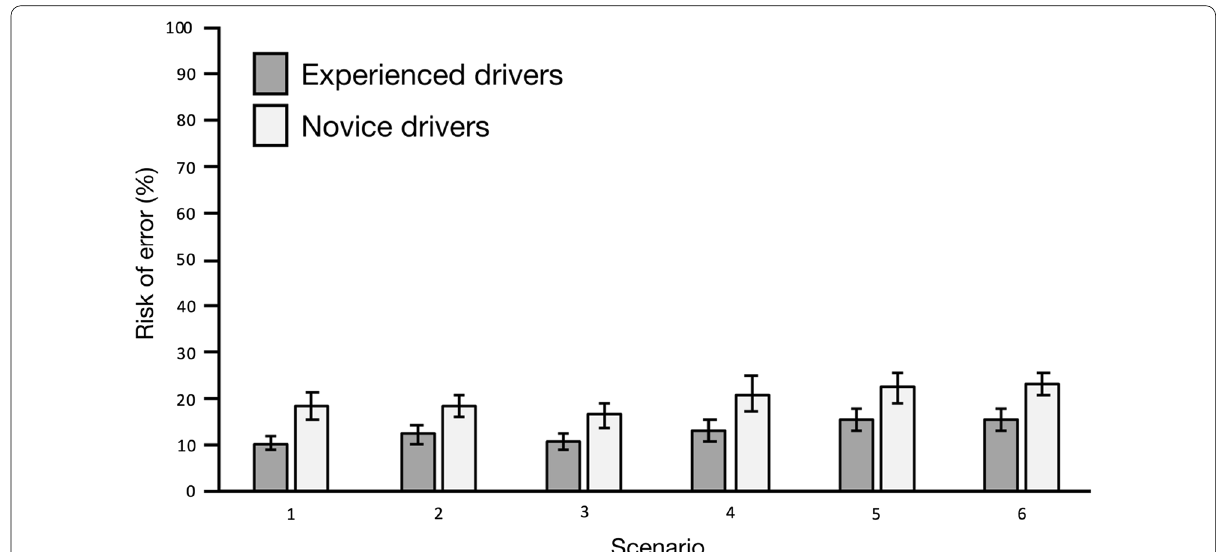
Fig. 3 Mean percentage of estimated risk of error decisions (